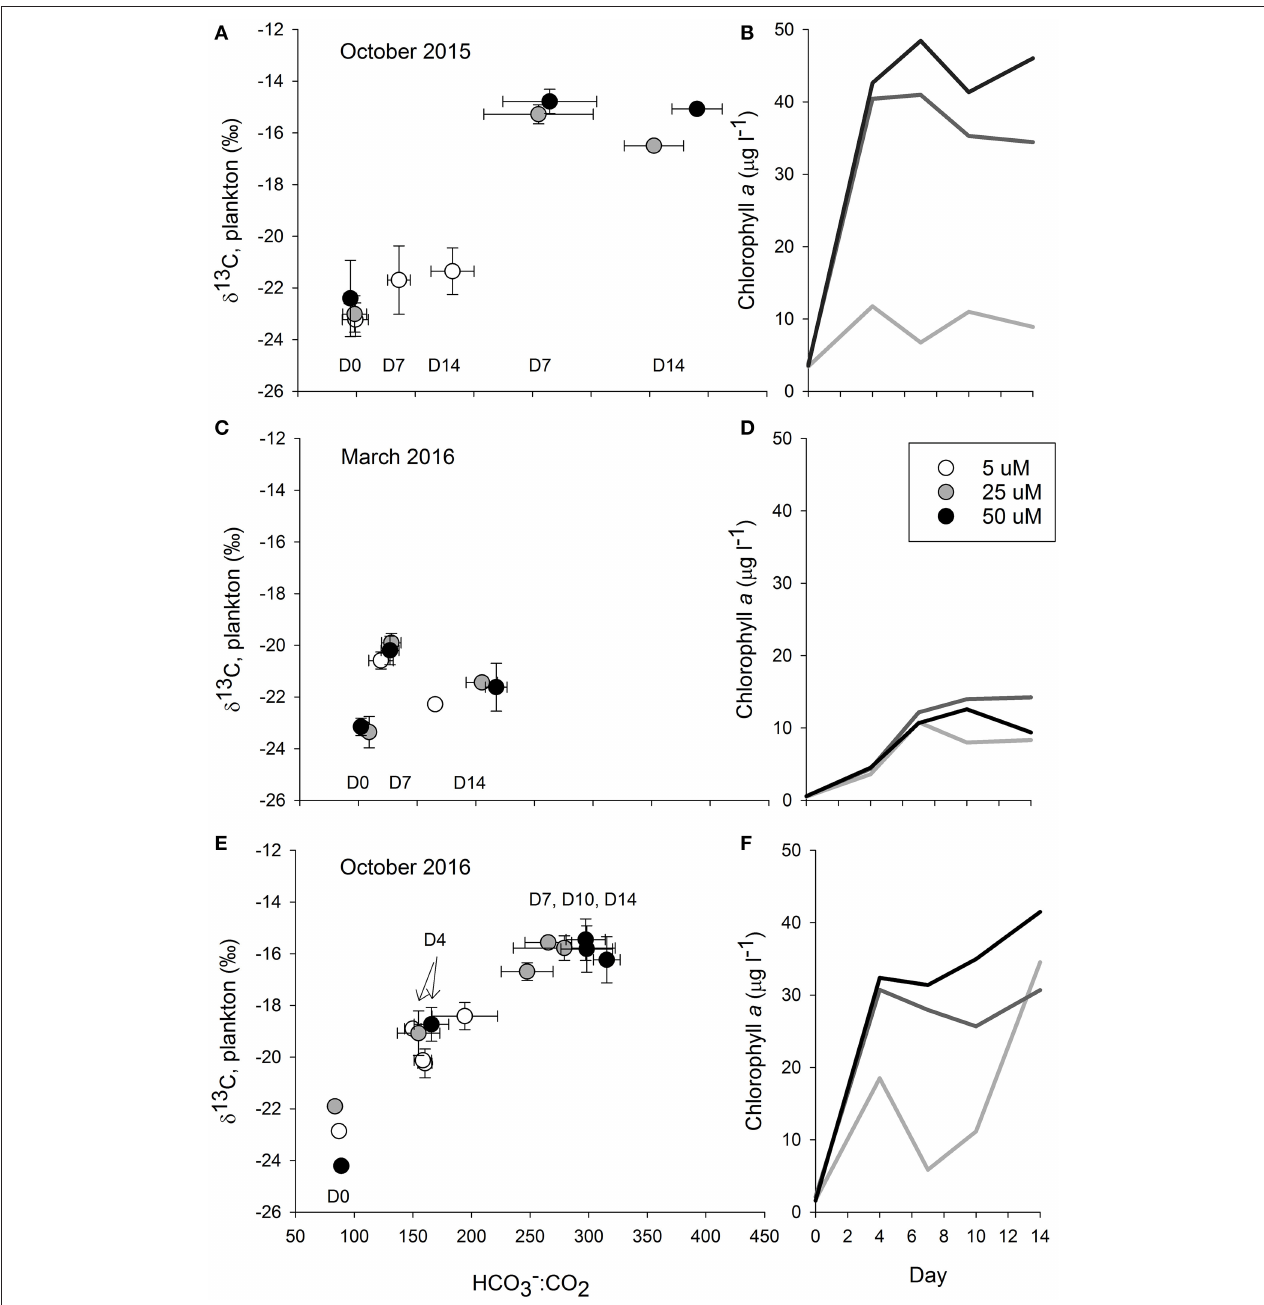
FIGURE 3 | The graphs in the left column plot bicarbonate to dissolved carbon dioxide ratios (HCO − 3 :CO 2 ) against δ 13 C values measured in plankton from the October 2015 (A,B) , March 2016 (C,D) , and October 2016 (E,F) Ecostat experiments. The carbonate parameters were calculated from measurements of temperature, salinity, and alkalinity in the effluent water stream while the δ 13 C values were from plankton captured on glass fiber filters. As the resultant relationships were roughly chronological, we indicated the day of the experiment using the notation D for day followed by the experimental day (e.g., D7 is day seven). The color of the circle and or line corresponds to the level of nutrient enrichment, with darker colors indicating higher enrichment. Error bars show the standard deviation around the means of the three replicate treatments for both the X and Y axes. Chlorophyll concentrations from each of the three experiments are given, over time, in the right column. The shading of the lines corresponds to the level of treatment where the lighter color is associated with the lower enrichment (5 µ M) and the darkest color with the highest enrichment (50 µ M).